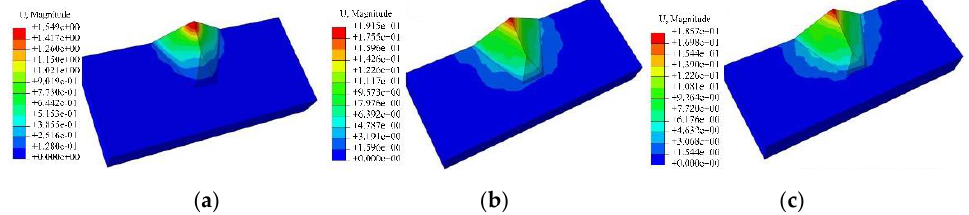
Figure 15. The displacement clouds map of ridge slope after excavation under different excavation slope rates (Unit: m). (a) The excavation slope ratio is 1:1.5; (b) the excavation slope ratio is 1:1.25; (c) the excavation slope ratio is 1:1.